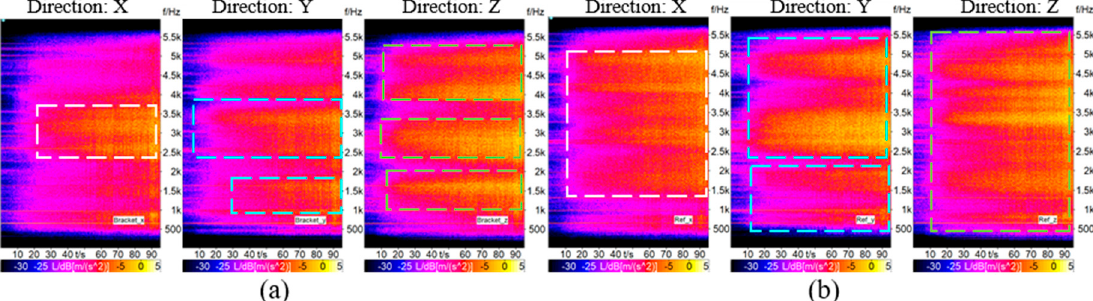
Figure 8. Colormap of vibration acceleration at bearing: ( a ) 1st gear; ( b ) 1st gear pre-selection 4th.